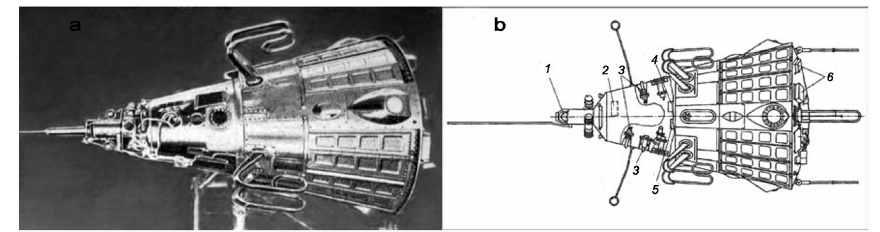
Figure 16. Appearance (a) and layout of the scientific equipment (b) of Sputnik 3: 1 – magnetometer; 2 – instrument for photon registration in cosmic rays; 3 – magnetic and ionization manometers; 4, 5 – instruments for measuring cosmic intensity radiation; 6 – sensor for registration of micrometeorites (Petrukovich et al., 2009).